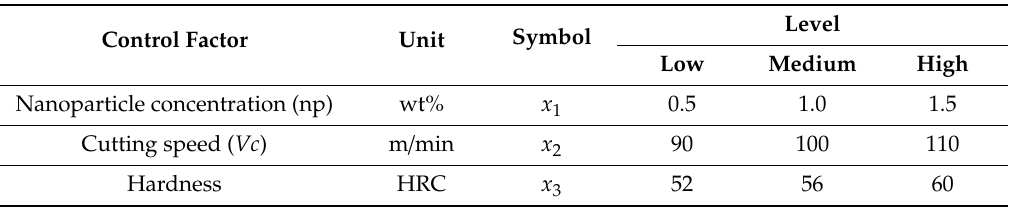
Table 2. Control factors and their